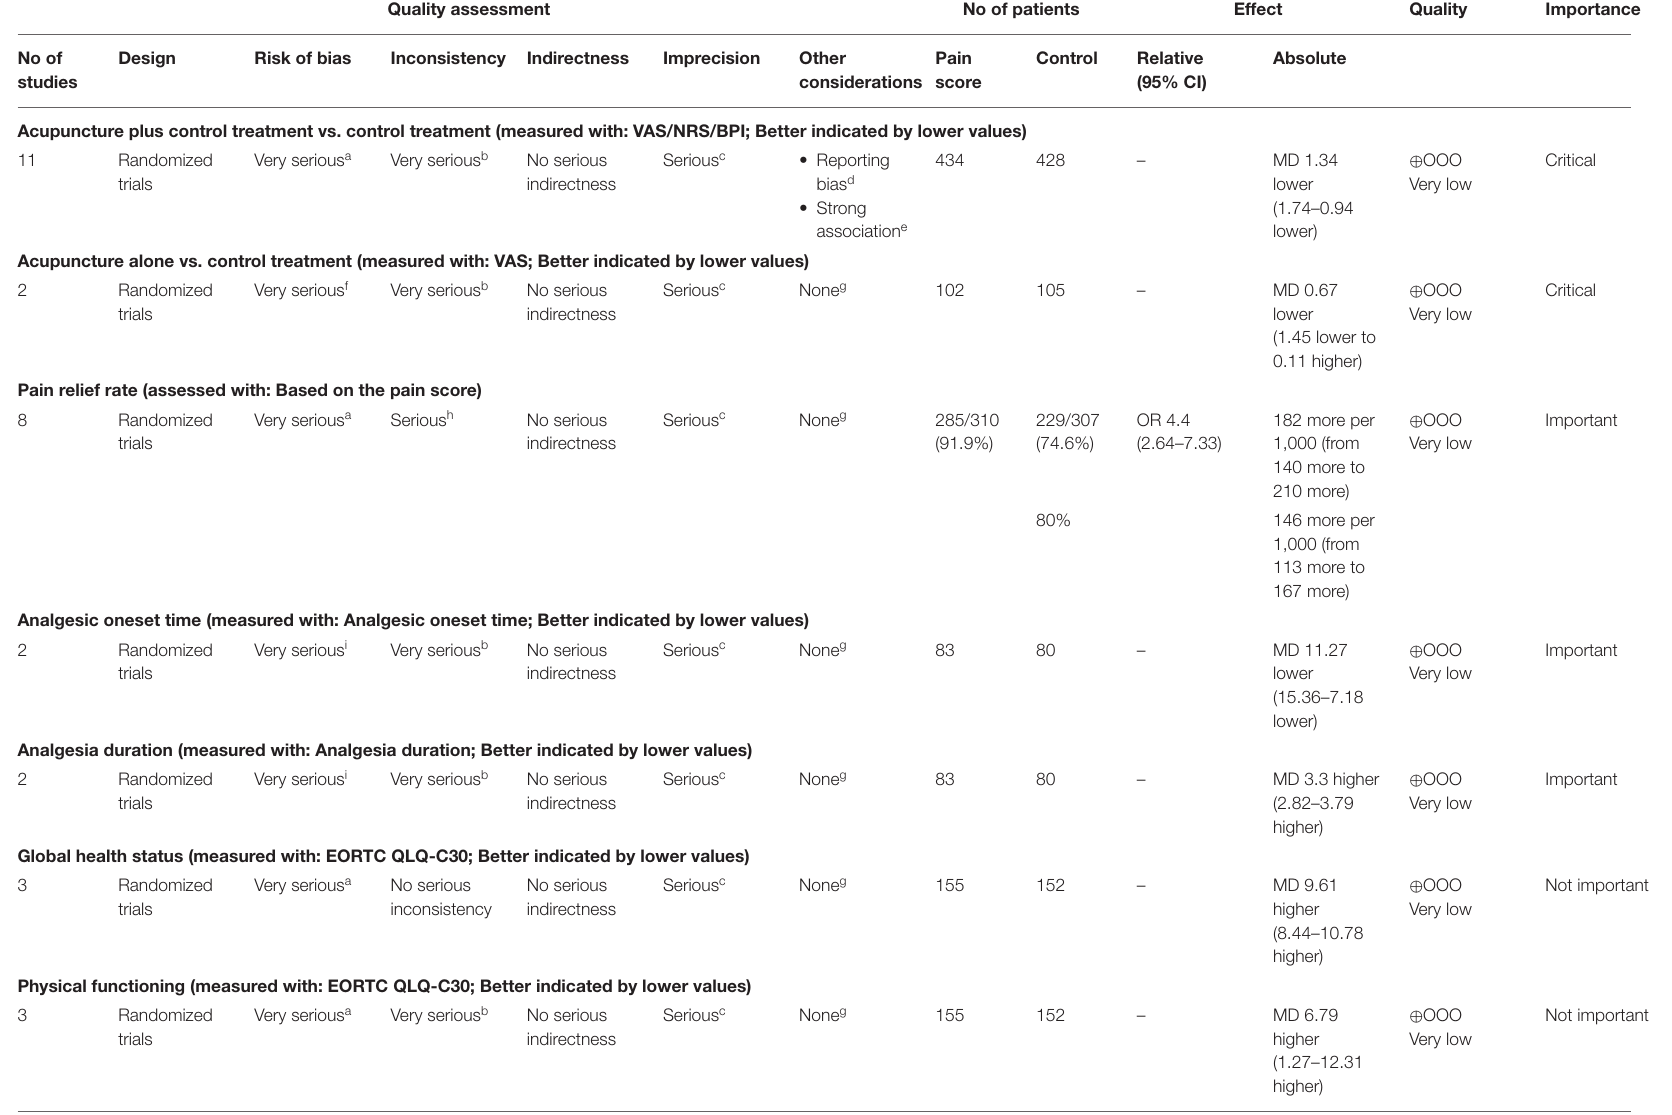
TABLE 6 | GRADE evidence profile of